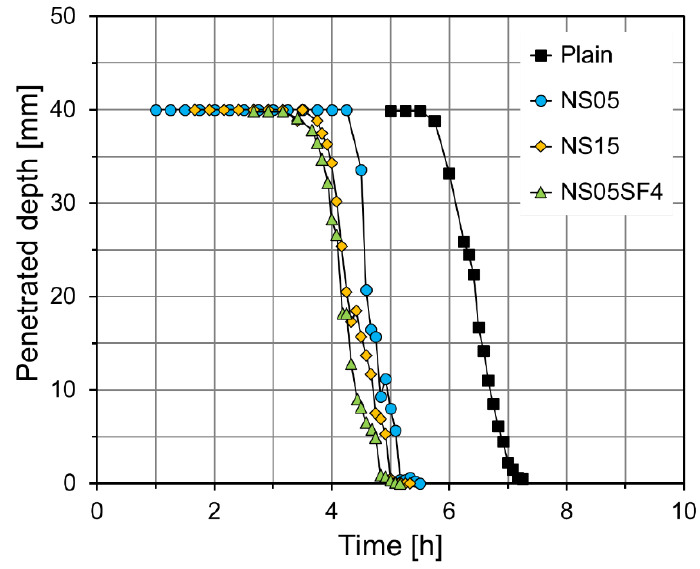
Figure 5. Results of Vicat needle test on the specimens.